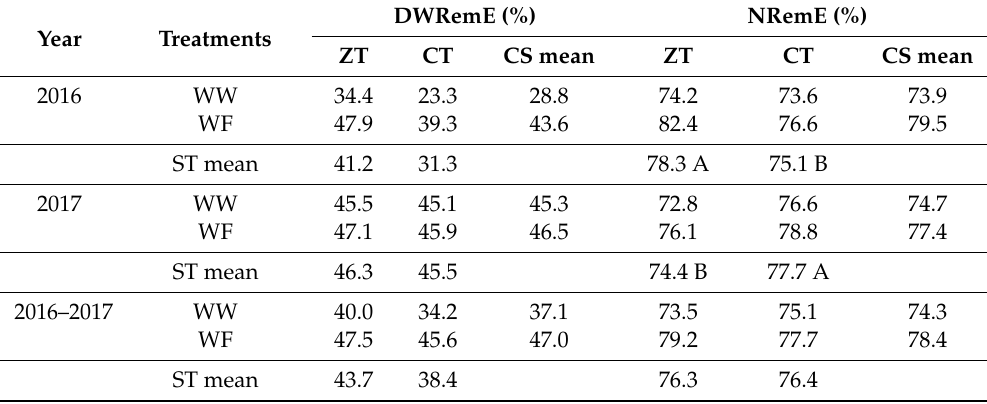
Table 2. Dry weight (DW) remobilization e ffi ciency (DWRemE, % of vegetative DW) and nitrogen (N) remobilization e ffi ciency (NRemE, % of vegetative N) in the 2016 and 2017 cropping seasons. Means followed by di ff erent letters (upper case letters: main e ff ects; lower case letters: e ff ects of interaction) significantly di ff er according to Tukey’s HSD test ( p < 0.05). Treatments: CT, conventional tillage; ZT, zero tillage; WW, durum wheat monocropping; WF, durum wheat-faba bean rotation.